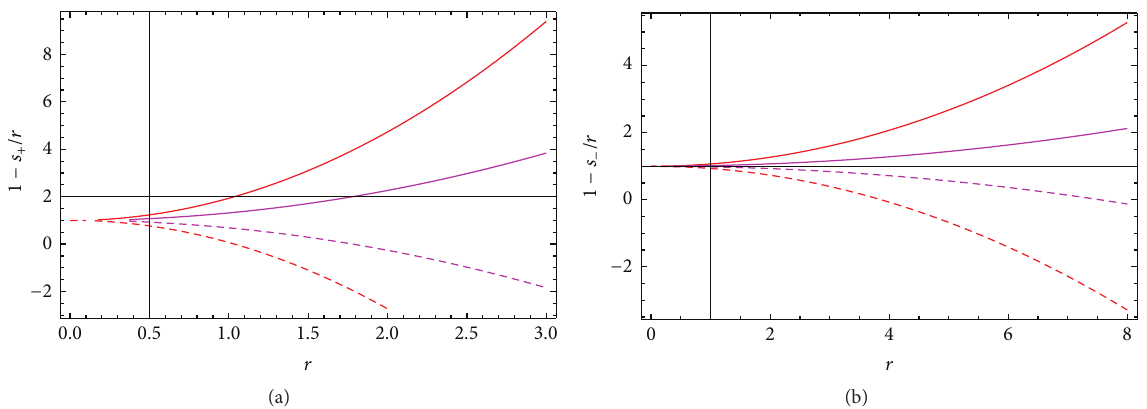
Figure 1: Plots of (a) 1 − 𝑠 + /𝑟 and (b) 1 − 𝑠 − /𝑟 versus 𝑟 in Gaussian distribution for 𝑛 = 5 , 𝜖 = 1 (red), 𝑛 = 5 , 𝜖 = −1 (red dashed), 𝑛 = 6 , 𝜖 = 3 (purple), and 𝑛 = 6 , 𝜖 = −3 (purple